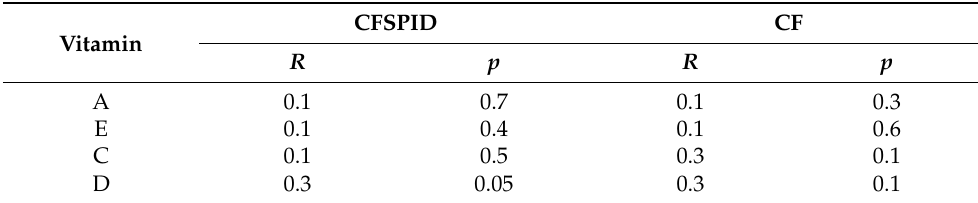
Table 4. Distribution of the content of vitamins A, D, E, and C in diets of particular groups.